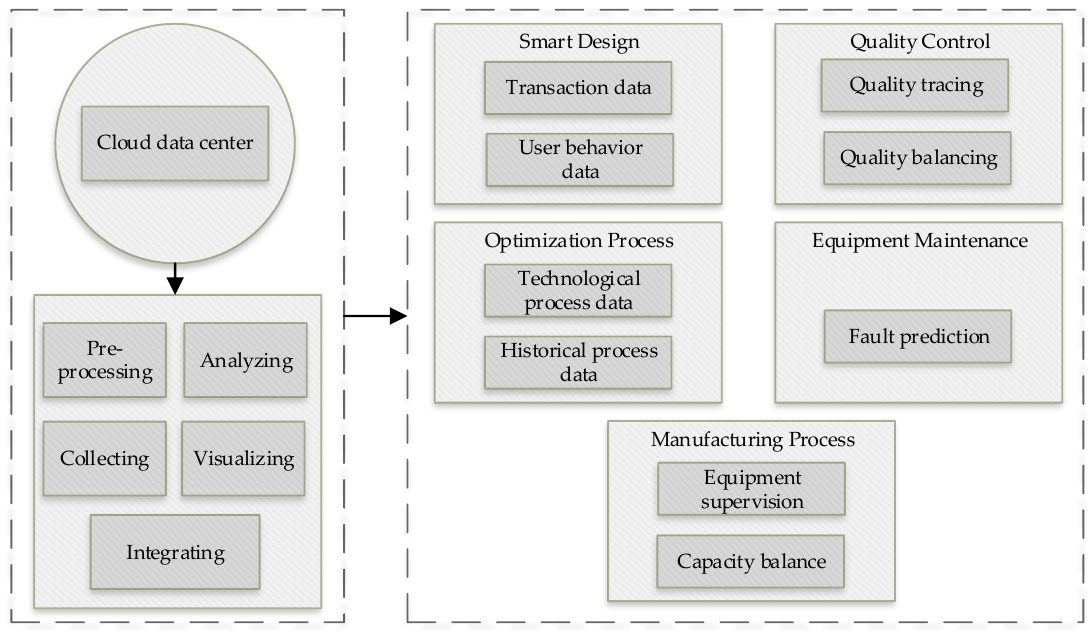
Figure 7. Data-driven